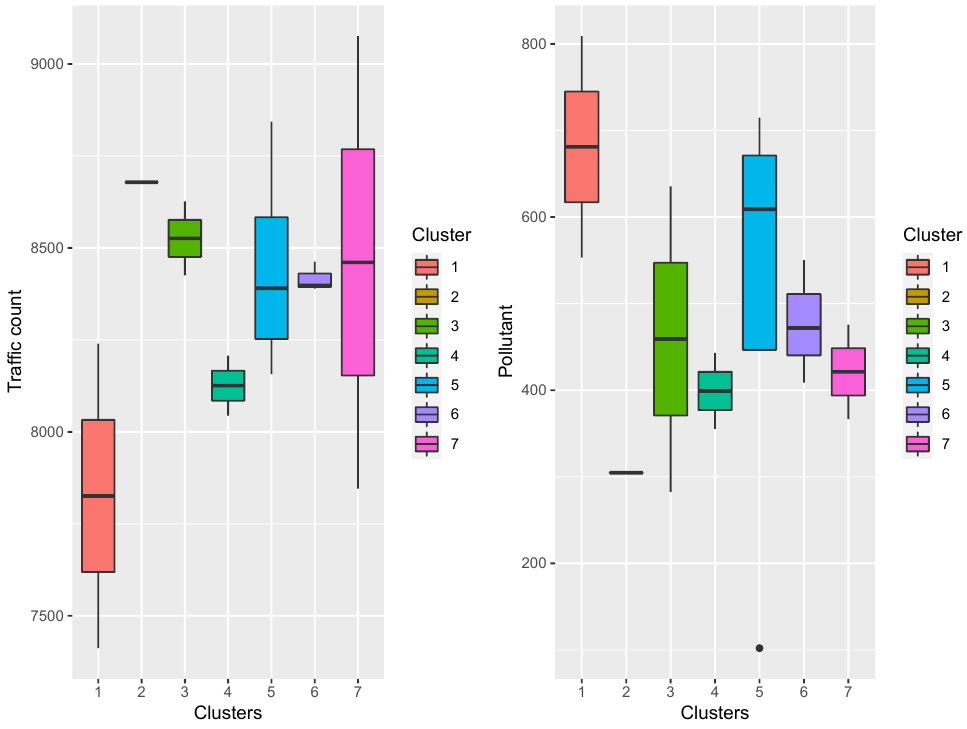
Figure 21. Clustering results applied to several weeks of data and visualization of O 3 and traffic